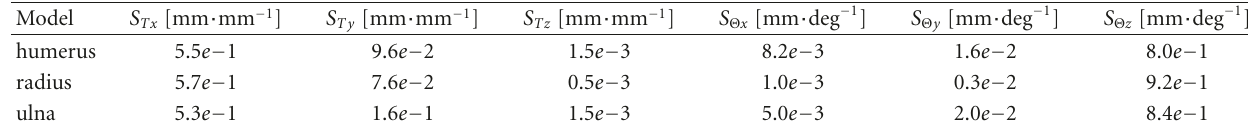
Table 1: Sensitivity of the RMSD to the variation of the 6DOF.